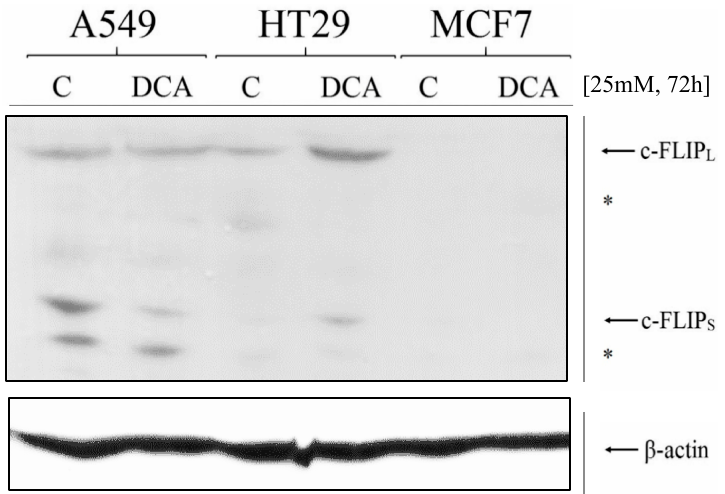
Figure 4. c-FLIP expression after DCA exposure. A549, HT29, and MCF7 cells were incubated for 72 h with DCA (25 mM) and then c-FLIP levels were measured by immunoblot. Non-specific bands are indicated by an asterisk (*). DCA: dichloroacetate.